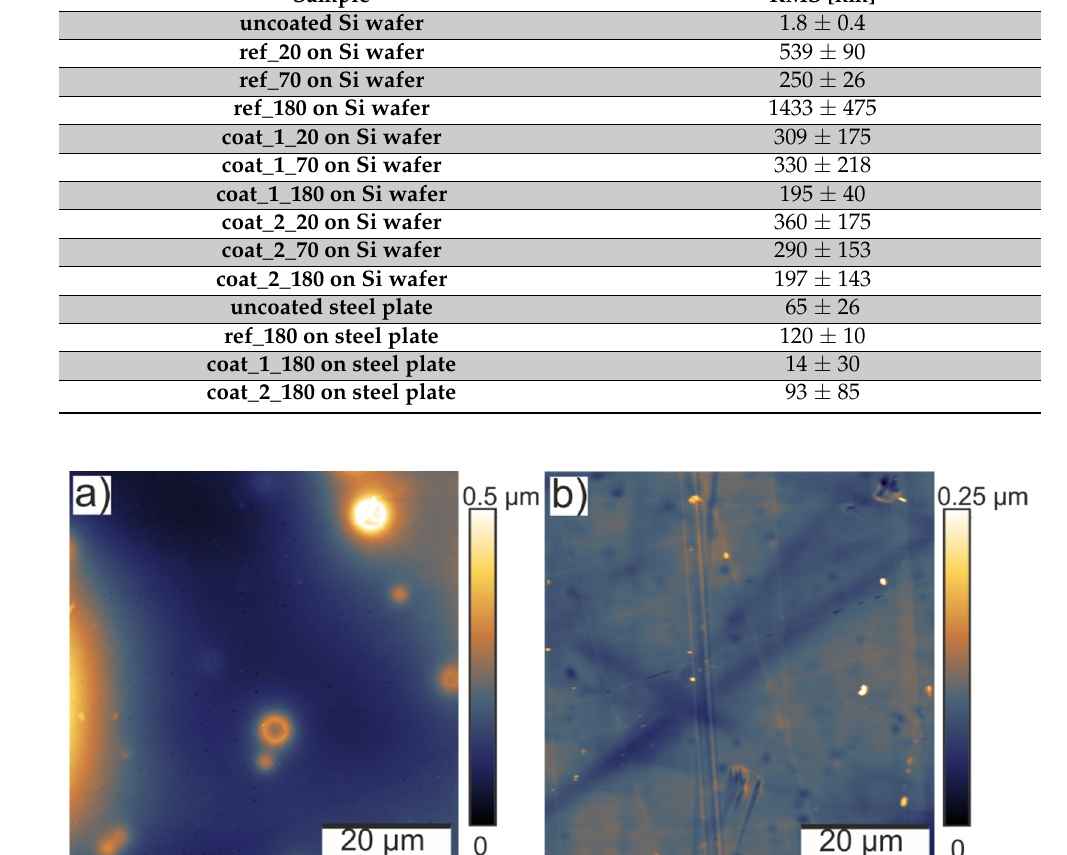
Table 3. Root mean square values of Si wafers and steel plates prior to activation and coating, as well as coated with the reference coating, coat_1_and coat_2. The samples were prepared at evaporation temperatures of 20, 70 and 180 ◦ C, respectively. Figure 8. Images of uncoated and coated Si wafers and steel plates under UV irradiation ( λ = 365 nm); top row: ( a ) uncoated Si wafer, ( b ) ref_180, ( c ) coat_1_180 and ( d ) coat_2_180 on Si wafers; bottom row: ( e ) ref_180, ( f ) coat_1_180 and ( g ) coat_2_180 on steel plates.